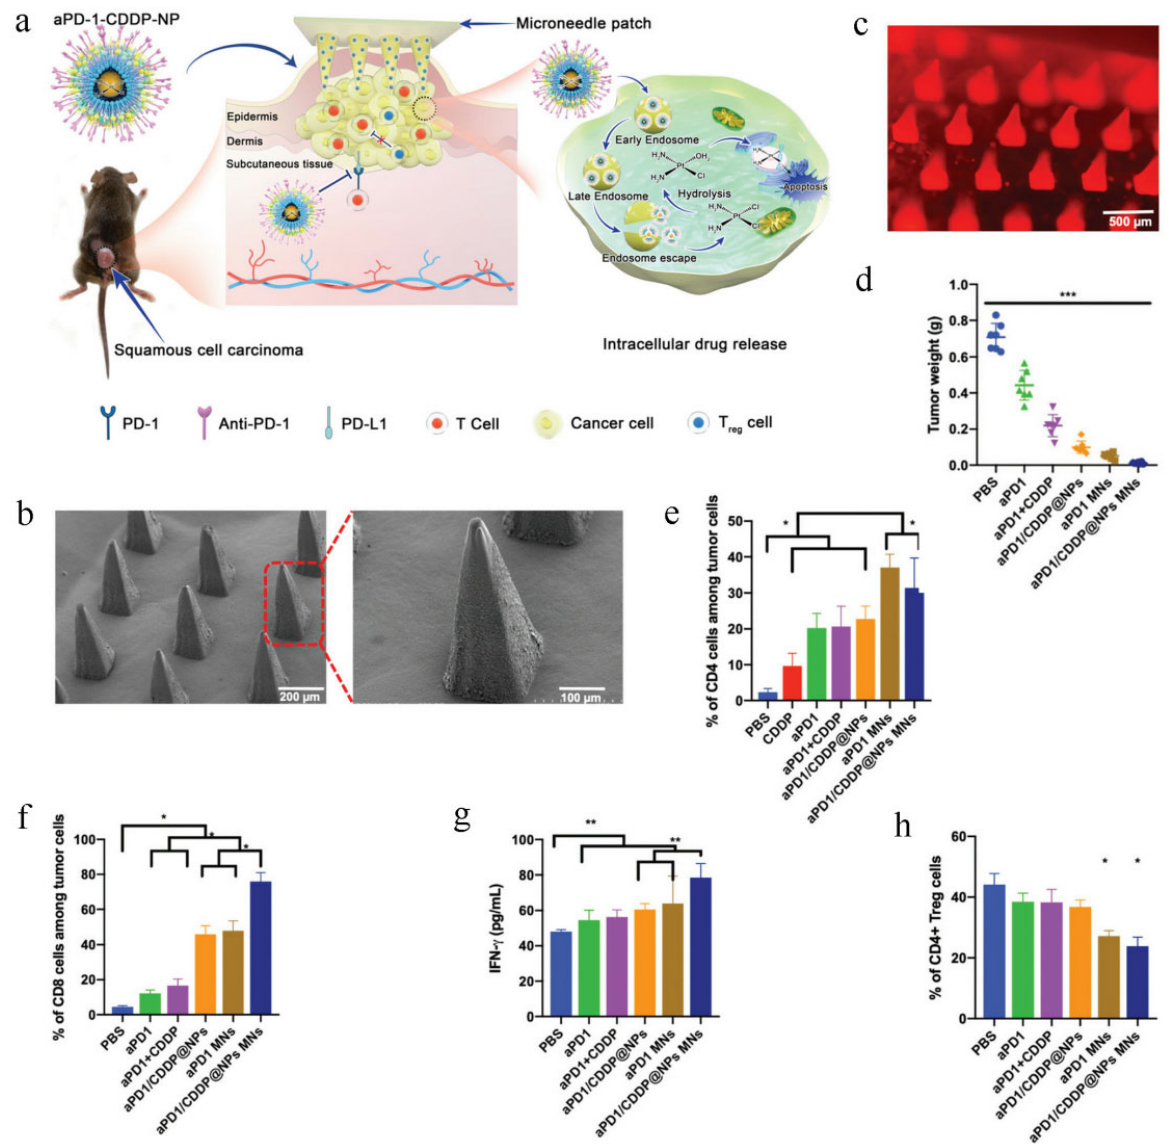
Figure 8. Schematic diagram of synergistic effect of immunochemotherapy by a microneedle patch containing aPD-1/CDDP@NPs. Reprinted with permission from Ref. [258]. 2020, Royal Society of Chemistry. ( a ) The mechanism of enhanced immunotherapy induced by aPD-1/CDDP@NP MNs. ( b ) SEM images of dissolving microneedles. ( c ) Fluorescence microscopy image of the microneedles. ( d ) Antitumor efficacy in vivo. *** p < 0.001. ( e ) The positive rate of CD4+ T cells. * p < 0.05. ( f ) The positive rate of CD8+ T cells. * p < 0.05. ( g ) IFN- γ expression in the serum. ** p < 0.01. ( h ) The percentages of CD4+FOXP3+ Tregs. * p <